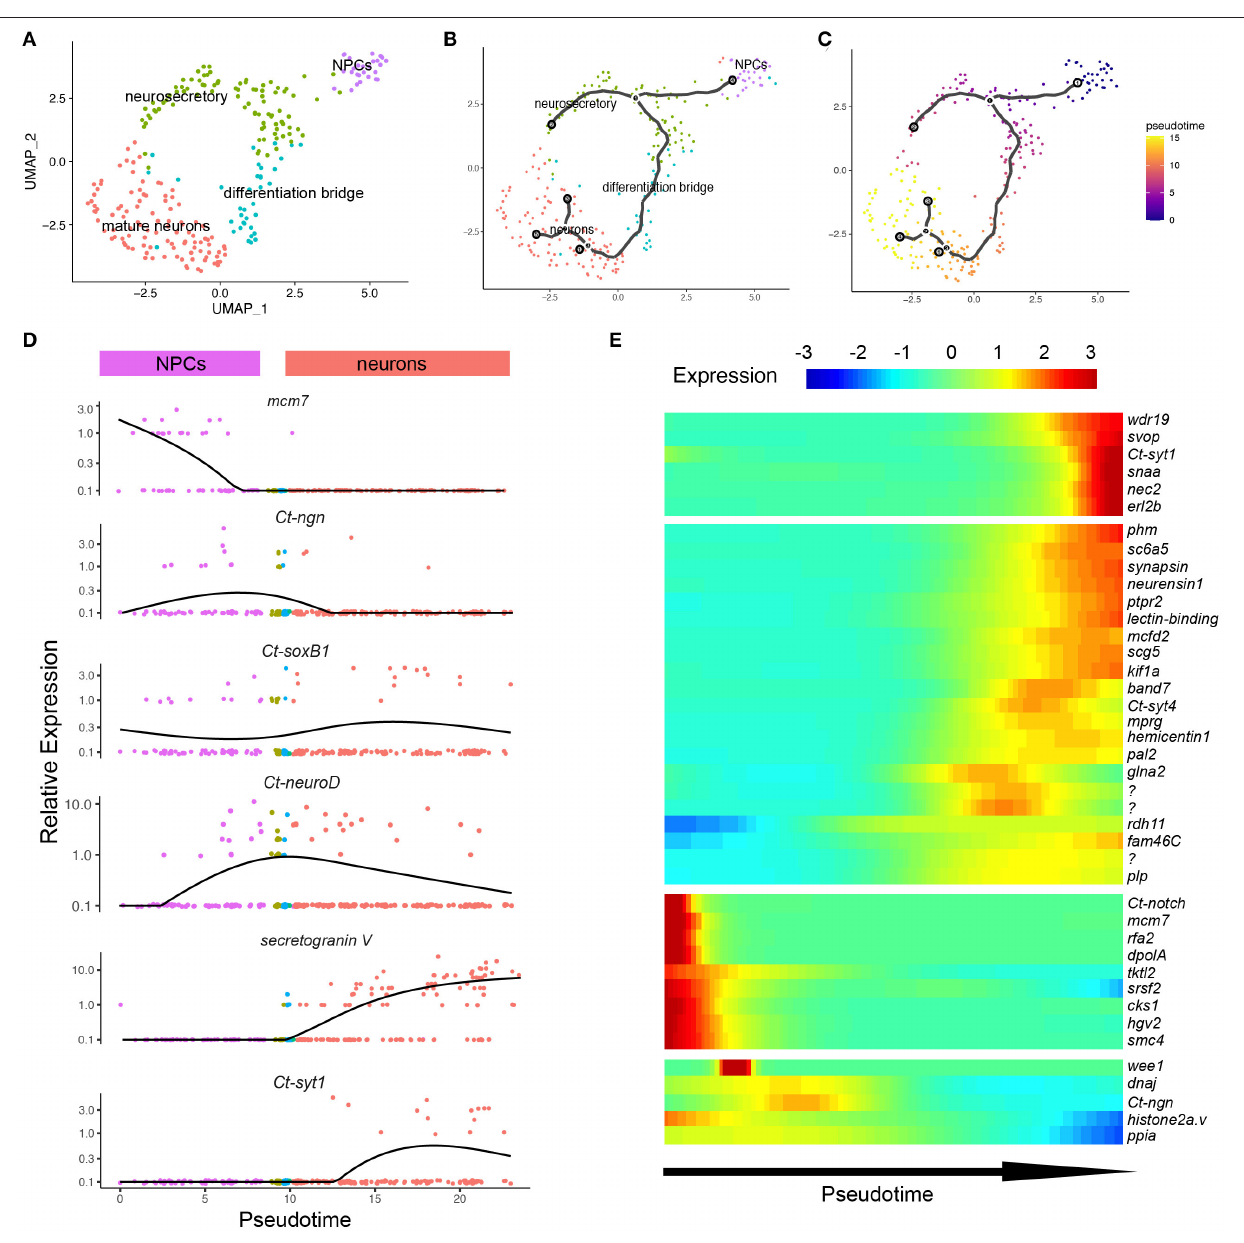
program during C. teleta neurogenesis. Neural subtype